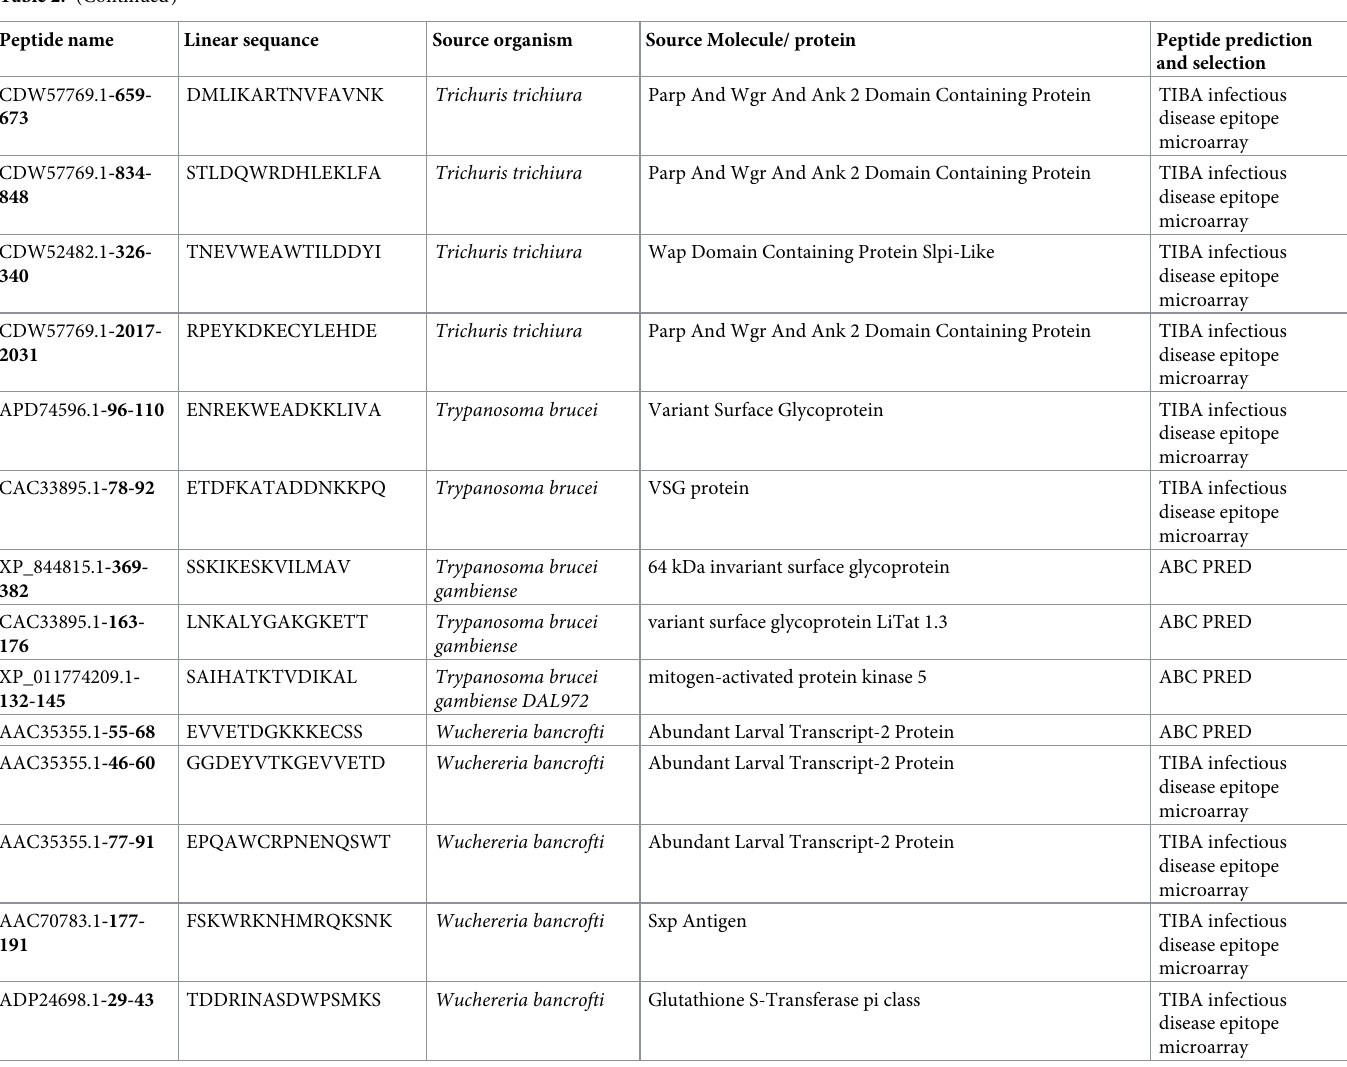
To ensure that all microarrays were responding correctly, all steps were repeated with the Cy3-conjugated anti-HA control antibody and Cy3-conjugated anti-polio control antibodies. Prior data quantification, all the peptide microarray scans were visually assessed for possible assay or microarray artifacts which would affect the experimental outcome. If required, the assays with individual samples were repeated on new peptide microarrays. For technical rea- sons, read-out for repeated samples was carried out with an Innopsys InnoScan 710-IR micro- array scanner with matching scanner